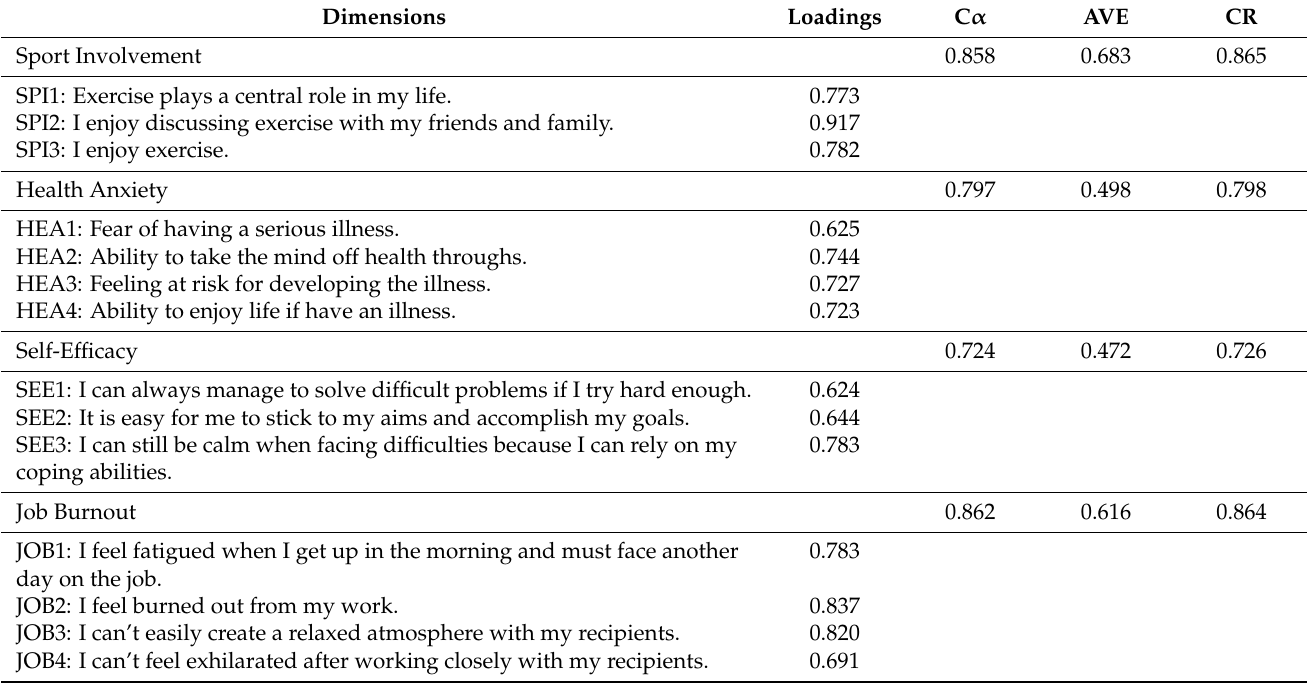
Table 2. Reliability and validity